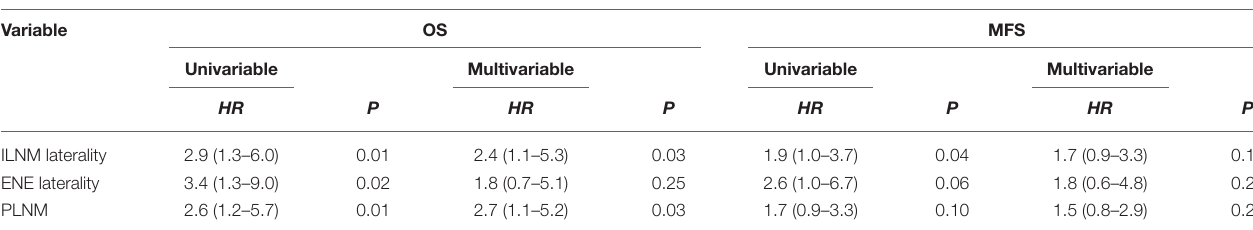
TABLE 4 | Univariable and multivariate Cox regression of OS and MFS. Variable OS MFS Univariable Multivariable Univariable Multivariable HR P